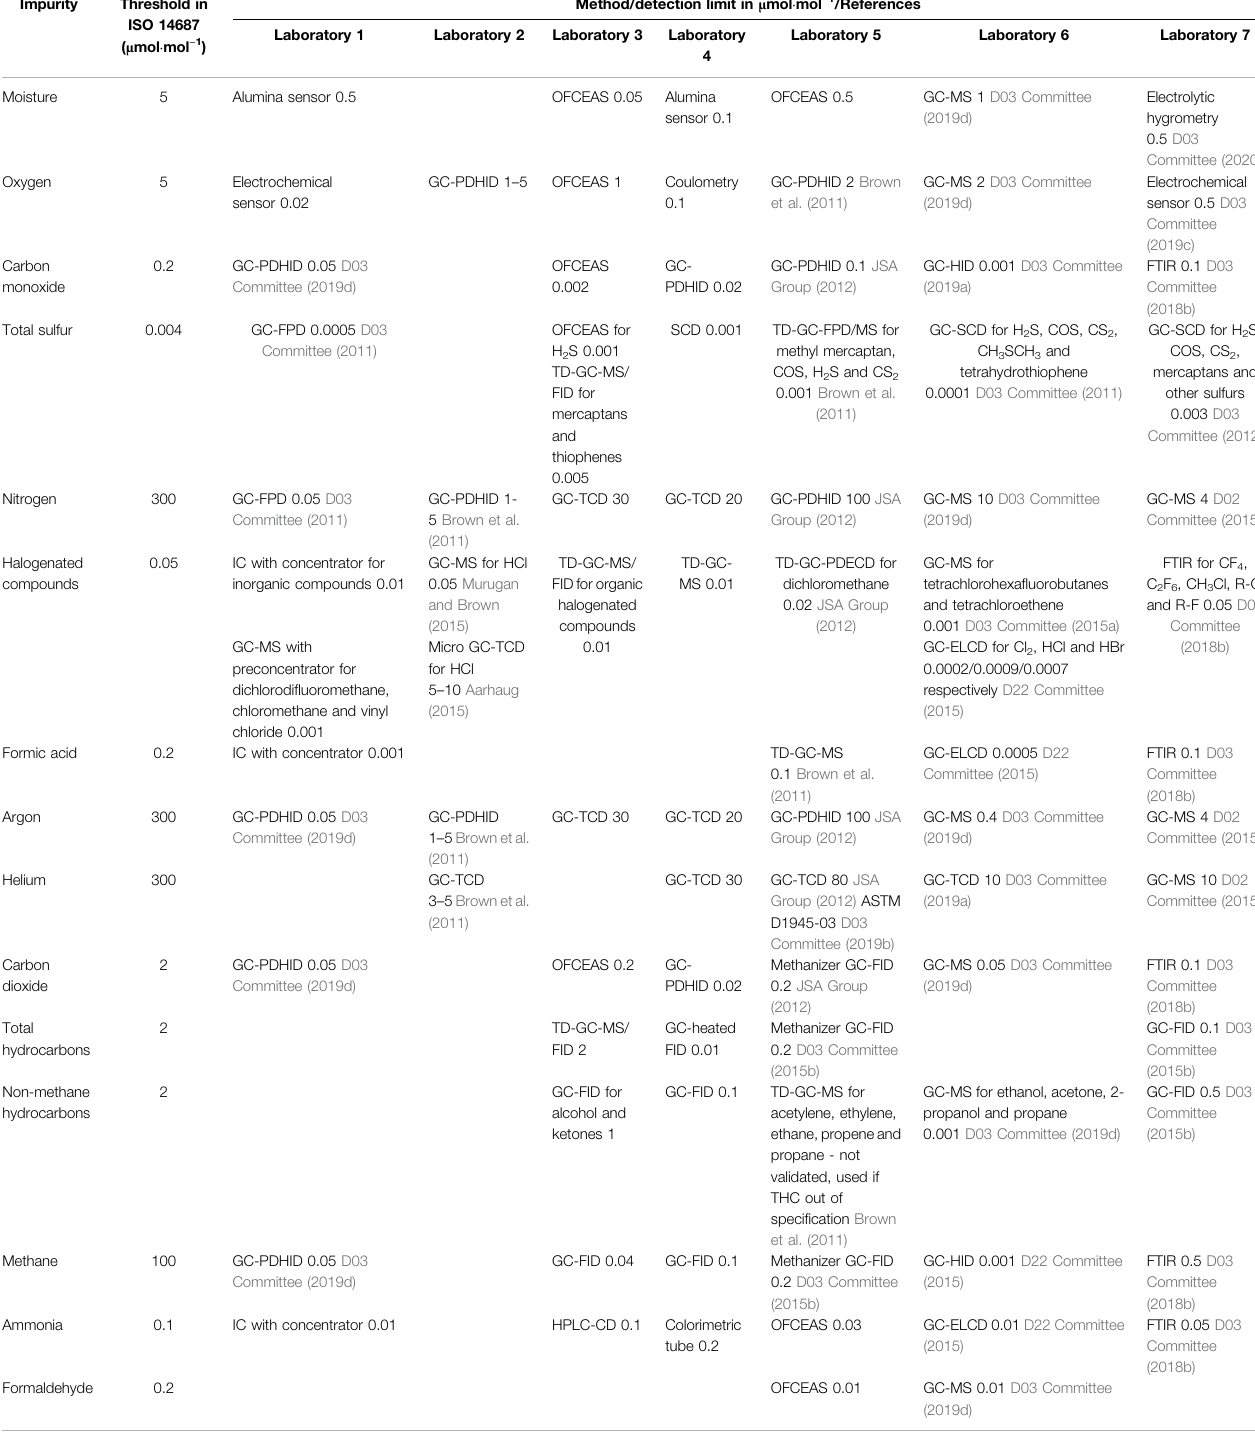
TABLE 11 | Methods used by the participants of the survey, by impurity and laboratory, with their corresponding detection limits and references (if